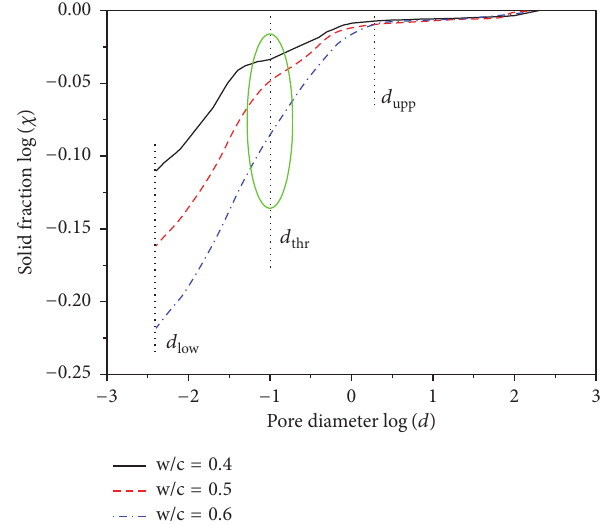
Figure 5: Porosimetric data of cement pastes with varying w/c ratios.